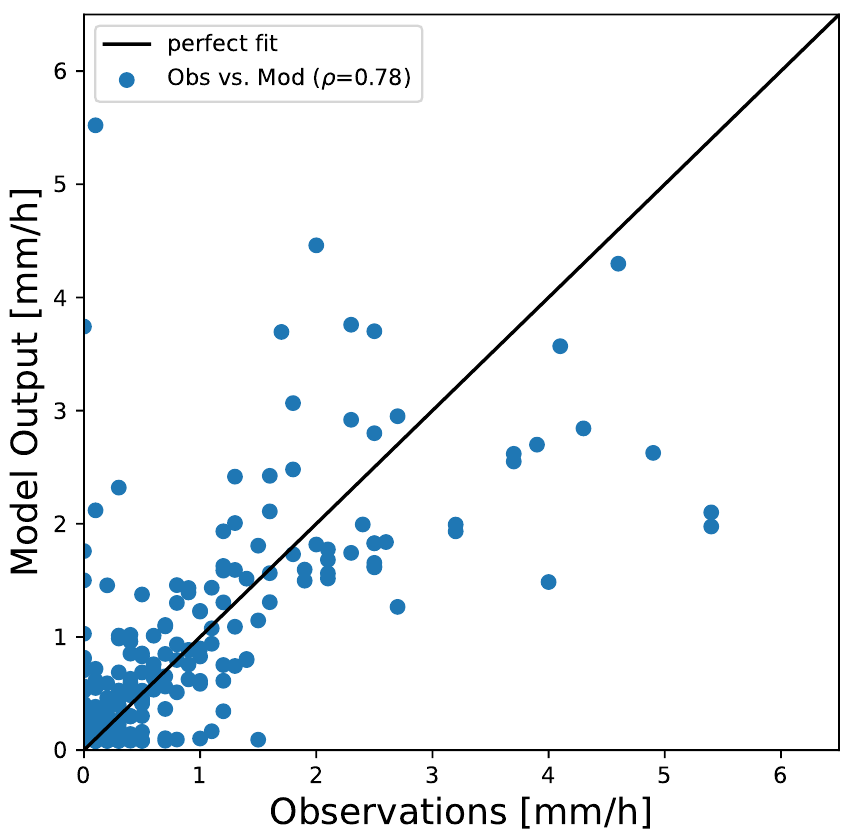
Figure 6. Scatter plot for observed (Obs) and modelled (Mod) precipitation at location Hohenpeis- senberg in an hourly resolution. Validation set (20% of the available data